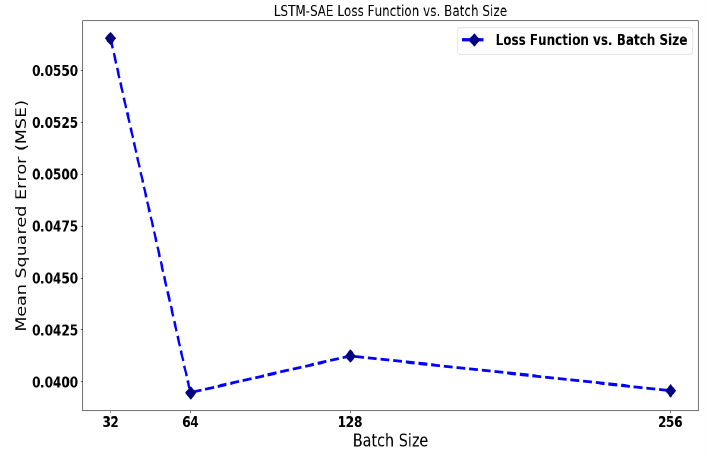
Figure 4. Loss Function vs. Batch Size: We observe that the lowest value of the Mean Squared Error (MSE) Loss function on the validation set (0.039) is achieved when we set the batch size into 64.